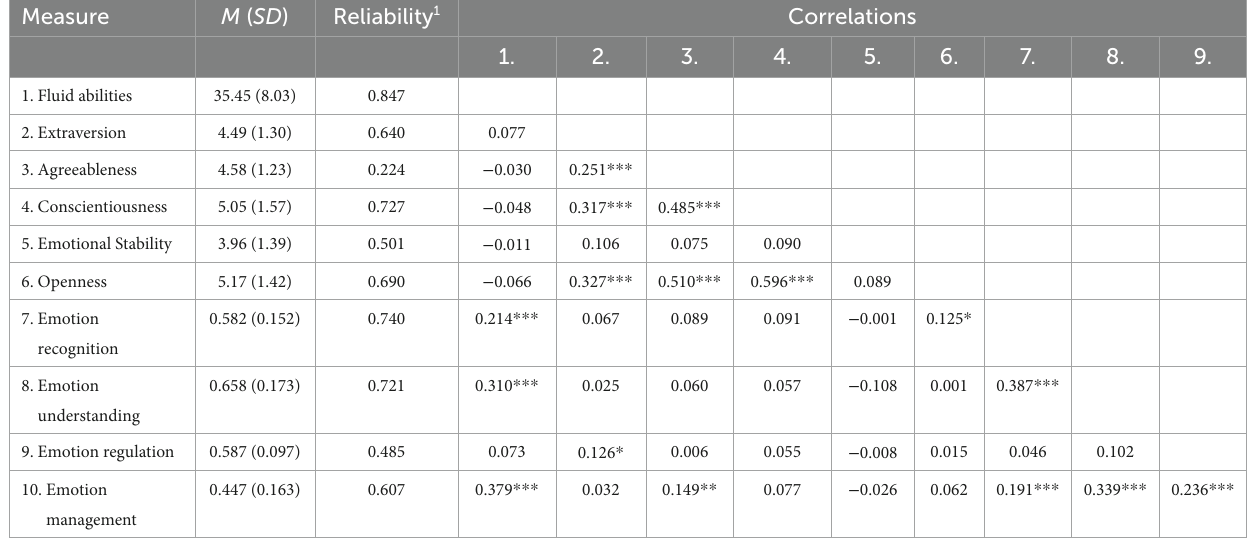
TABLE 3 Fluid ability, personality, and emotional abilities: descriptive statistics, internal consistencies, and correlations.